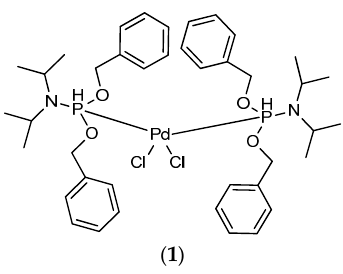
Figure 1. Palladium(II) complex ( 1 ).